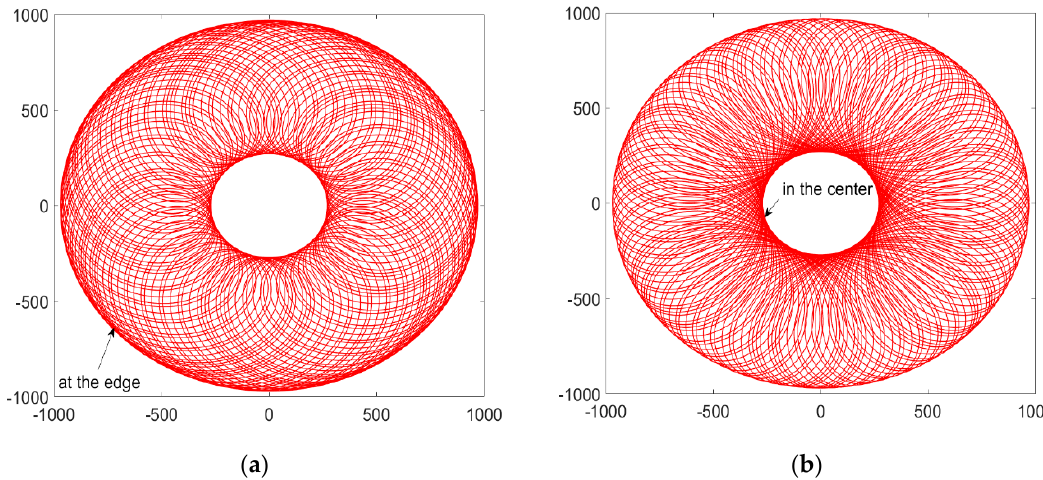
Figure 5. Paths described by a point at ρ = 350 mm in the system with a 217/37 gear ratio and a solar radius of 620 mm undergoing 24 revolutions in ( a ) standard planetary rotation and ( b ) counter planetary rotation.